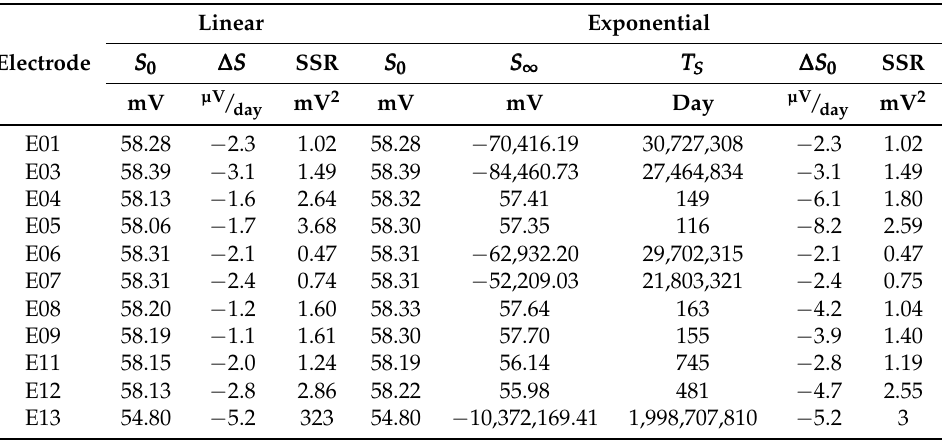
Table 2. Drift parameters of electrode slope approximated by linear or exponential functions. S 0 , initial value; ∆ S , daily change; SSR, sum of squares of residuals; S ∞ , final value; T S , time constant; ∆ S 0 , initial daily